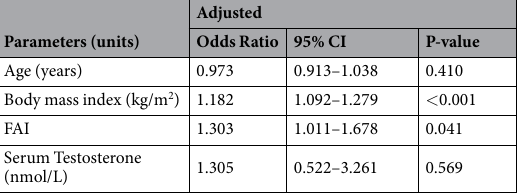
Table 6. Multiple logistic regression analysis for the androgen prediction of PCOS including age, body mass index, free androgen index and serum testosterone. salT – salivary testosterone. FAI – Free Androgen Index . Logistic regression taking into account age and body mass index (BMI) showing that in this model salivary testosterone (salT) is significantly more predictive of PCOS than the free androgen index (FAI) or serum T (Tables 5 and 6, respectively), and that FAI was more predictive than serum T